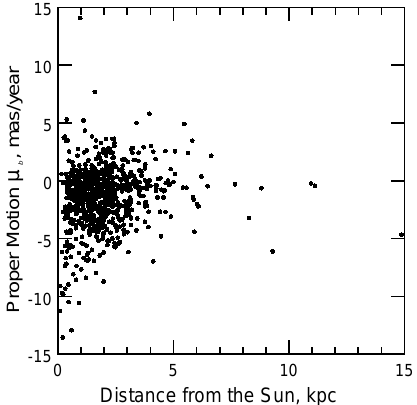
Fig. 2. The dependence of the galactic-latitude component of proper motion, µ b , of open clusters on heliocentric distance. For OCls of our sample in the distance interval 3 . 0 − 3 . 5 kpc the dispersion of radial velocities relative to the double wave was found to be 25.1 km s − 1 . The radial-velocity components of open clusters were corrected for the motion of